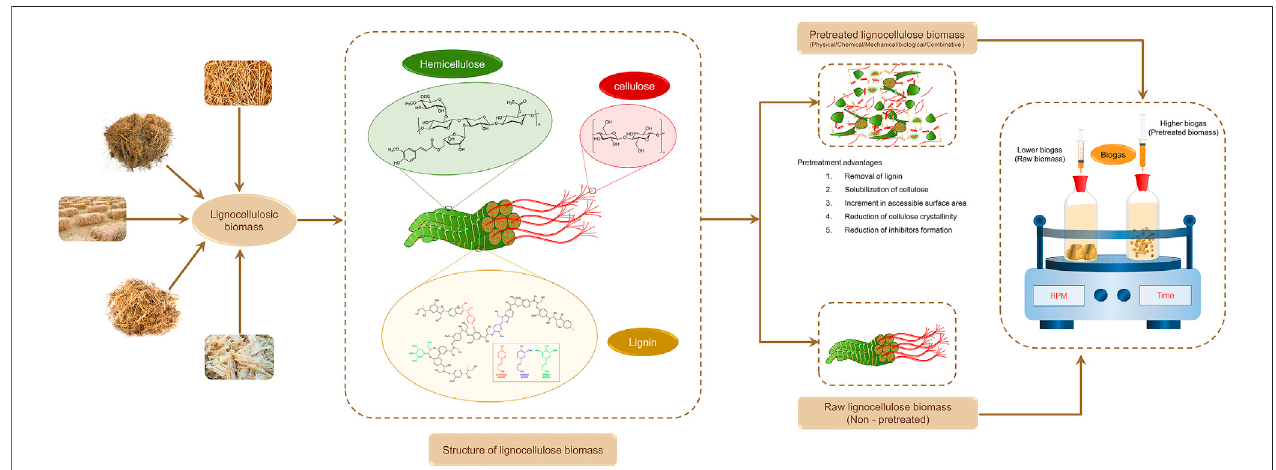
FIGURE 2 | Impact of LC biomass pretreatment on biomethane